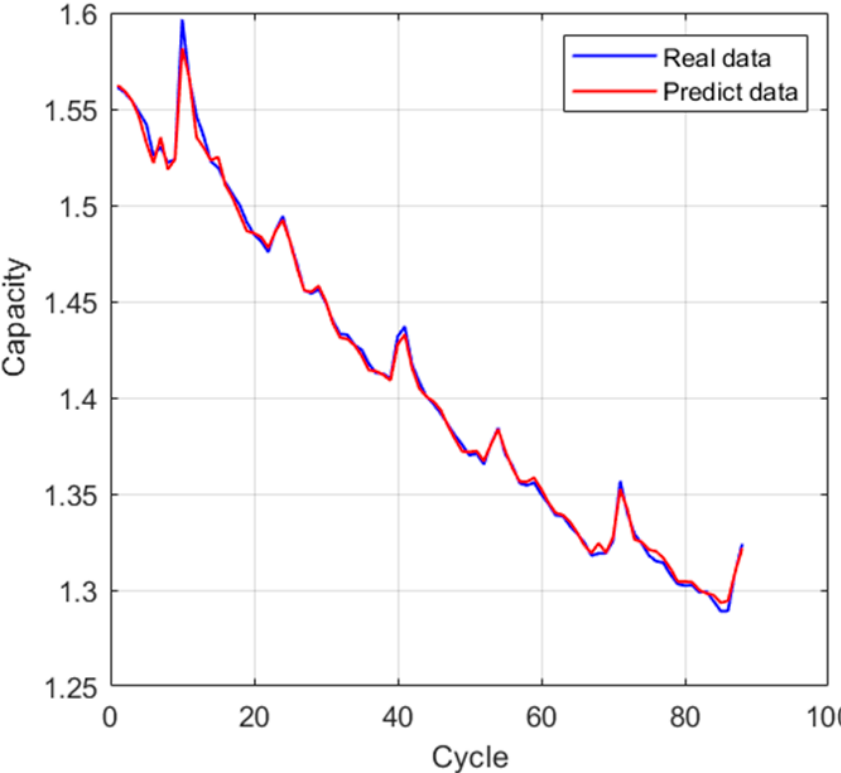
Figure 7. Capacity prediction results of the B0005 battery.